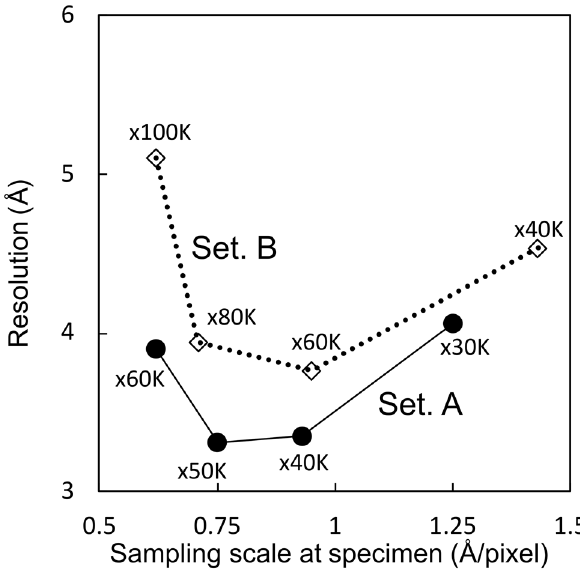
Figure 7. Plot of the achieved resolution of each magnification with different EM settings. The achieved resolutions of Setting A (solid dots) and Setting B (empty diamonds) at each magnification are connected by solid and dot lines, respectively. X-axis shows the sampling scale at the